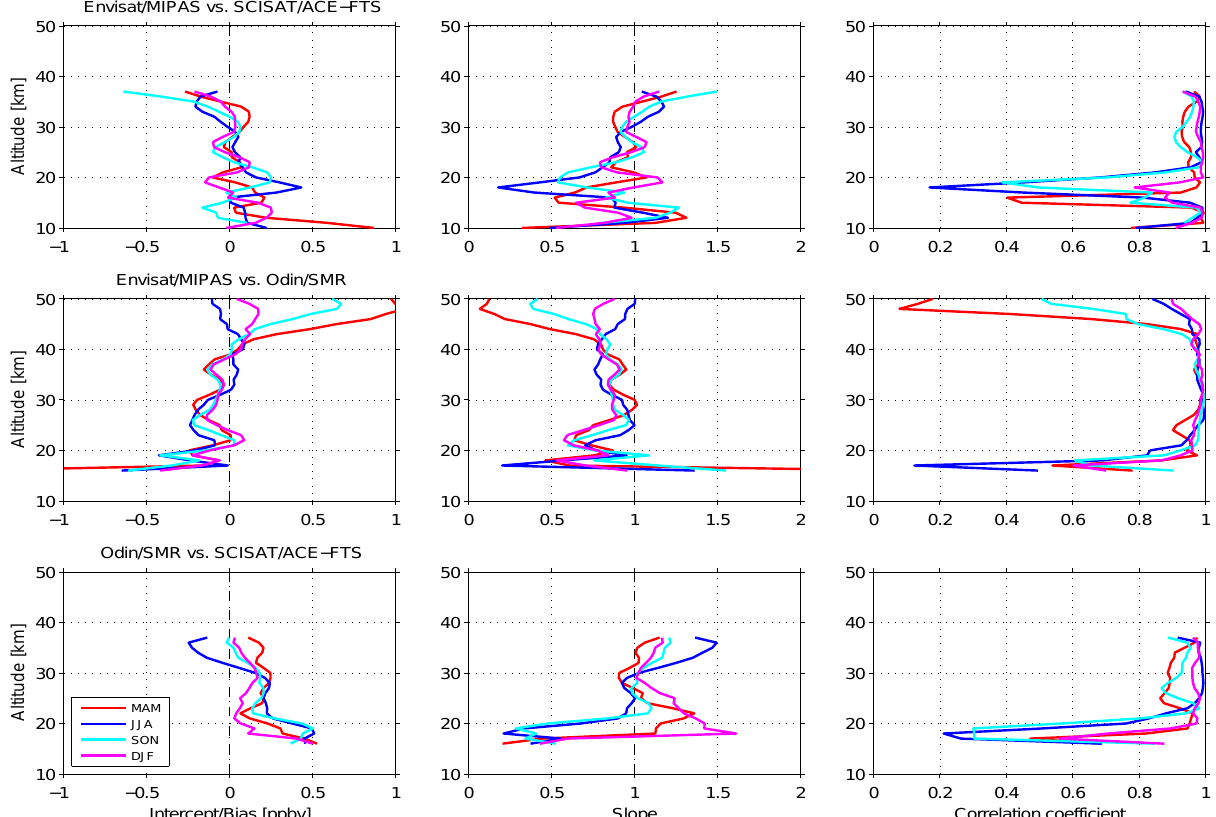
Fig. 6. Summary of the linear fit parameter and correlation coefficients derived from the seasonal comparisons of the latitudinal cross sections for the altitude range between 10km and 50km. The upper panels show the results for the comparison between MIPAS and ACE-FTS, the comparison between MIPAS and SMR is shown in the middle panels. The lower panels summarise the results of the comparison between SMR and ACE-FTS. The dashed lines indicate the optimal line fit